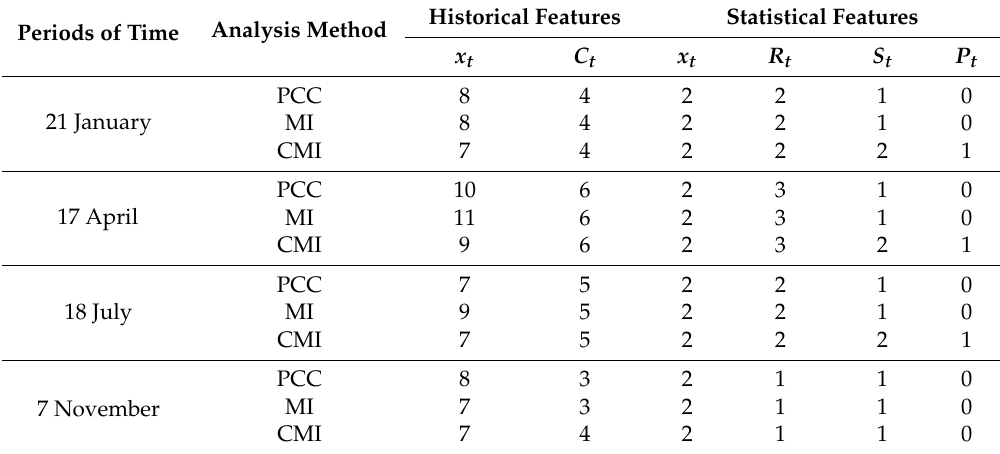
Table 7. The feature variety of the optimal feature subset obtained by AD-ORELM method. Periods of Time Analysis